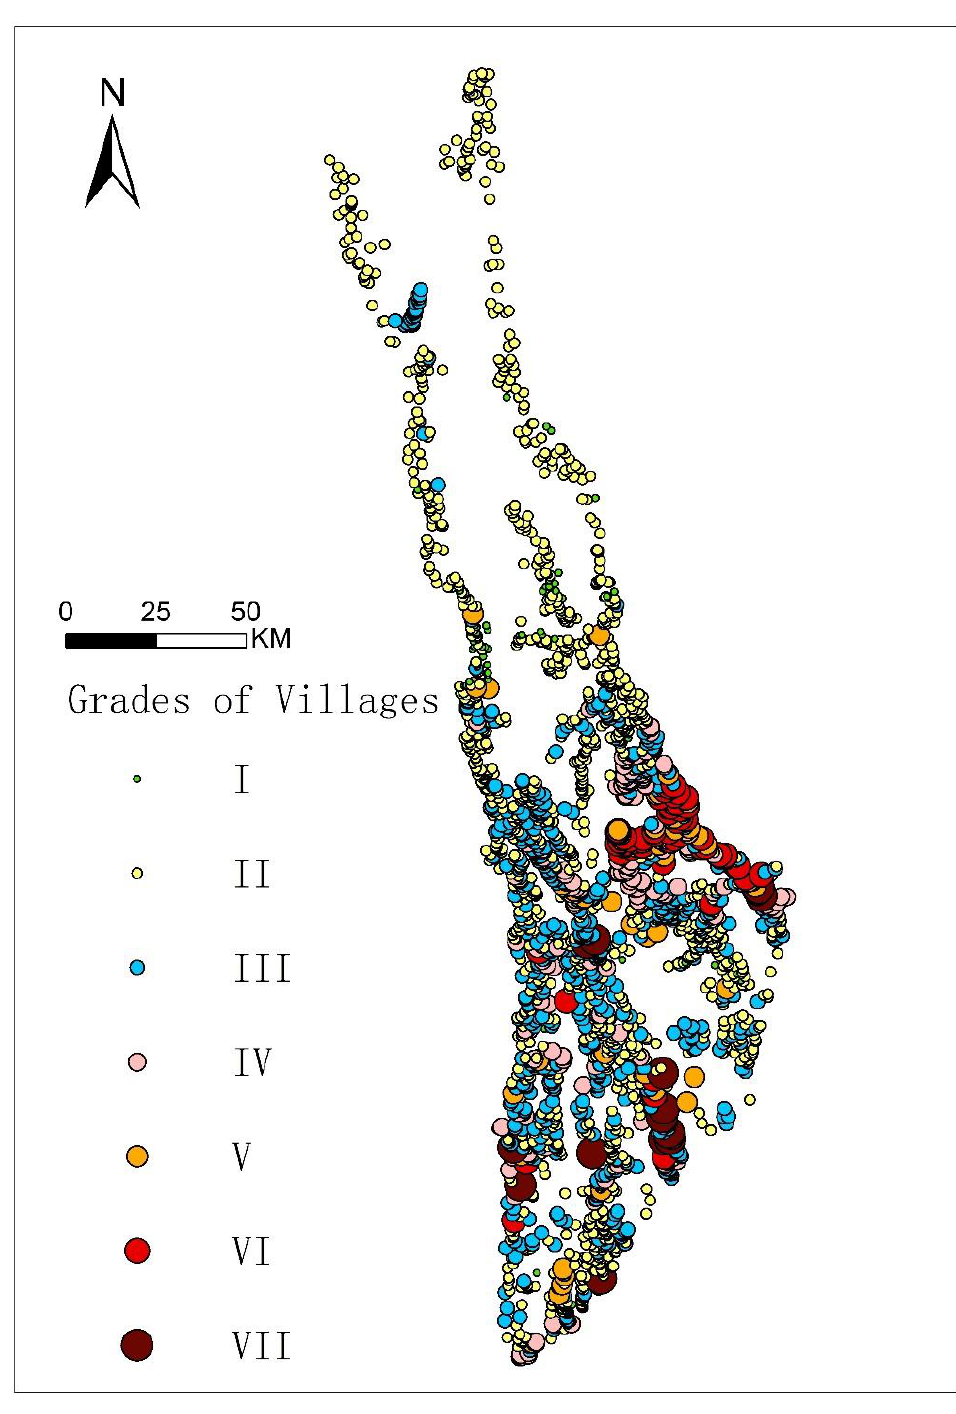
Figure 2. Distribution of villages and their grades in Northwest Yunnan.